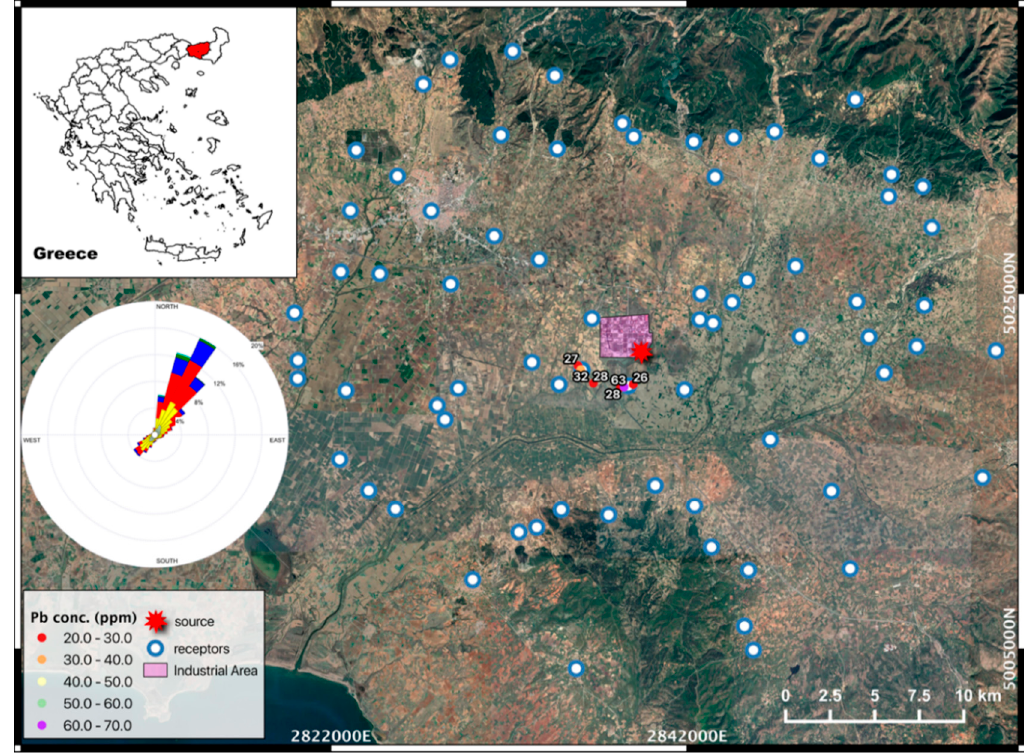
Figure 1. Study area with 72 discrete receptors and the source. Insert lists lead concentration detected in the topsoil of six locations. in the topsoil of six